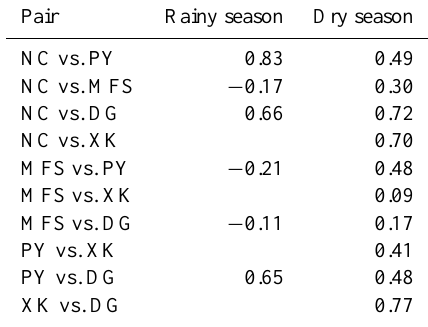
Table 1. Inter-site correlation (Pearson’s r ) of hourly light- absorption data in the Pearl River delta